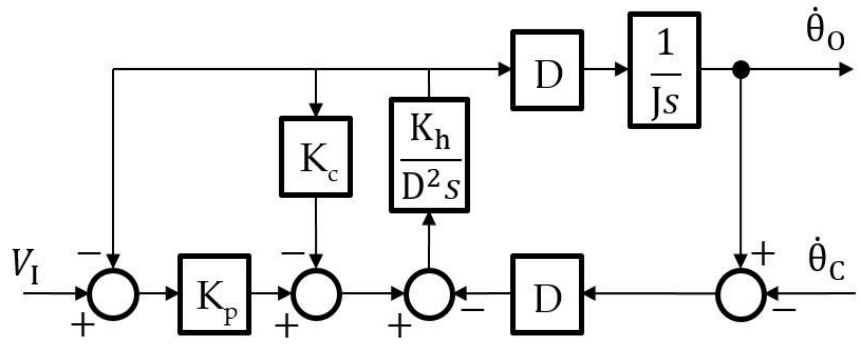
Figure 2. Base motion power spectral density.